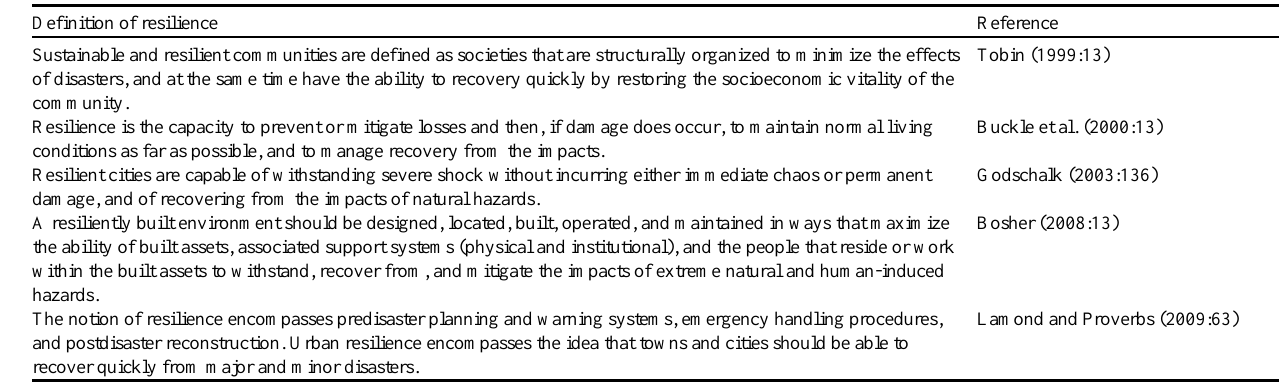
Table 2 . Some existing definitions of community resilience that are akin to engineering resilience. Definition of